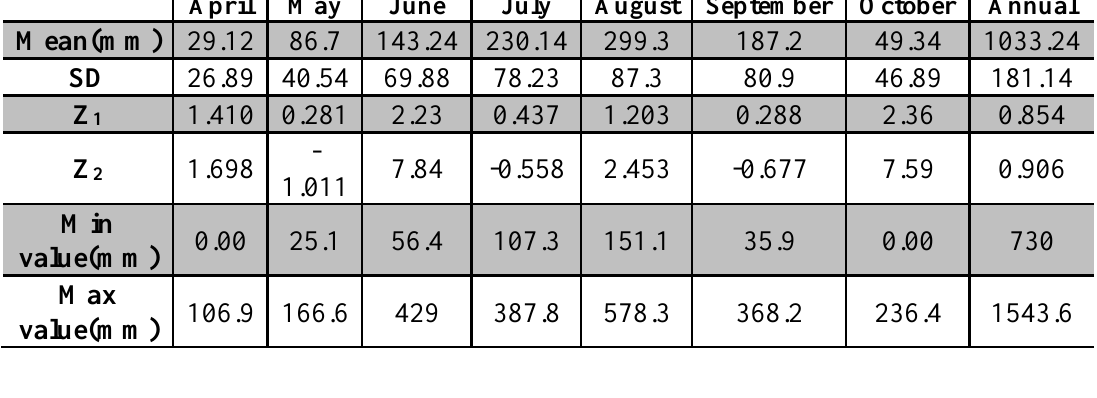
Table 3: Summary statistics for Rainfall in Gombe metropolis 1990-2020.